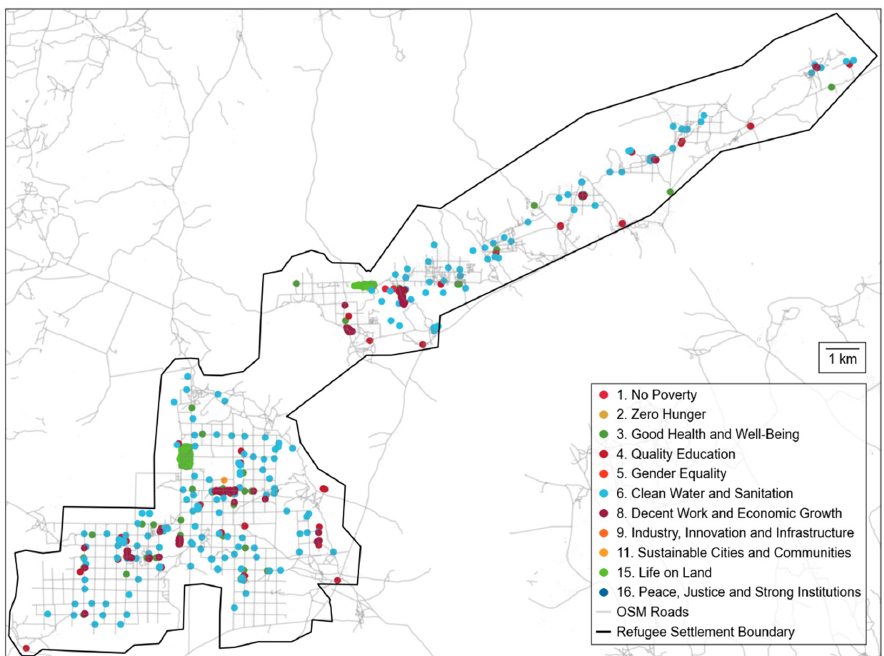
Figure 8. Map of SDG-relevant OSM features in Palorinya Refugee Settlement, which are primarily associated with SDG 6 (Clean Water and Sanitation) and located along roadways. See Appendix A Figure A1 for all refugee settlement OSM feature coverage maps.